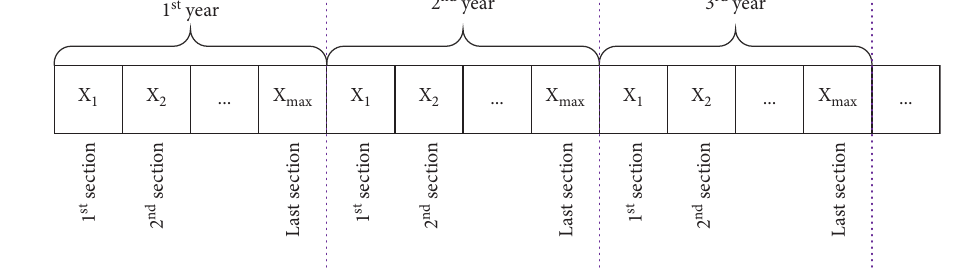
Figure 2: Representation of decision variables (M&R plan).